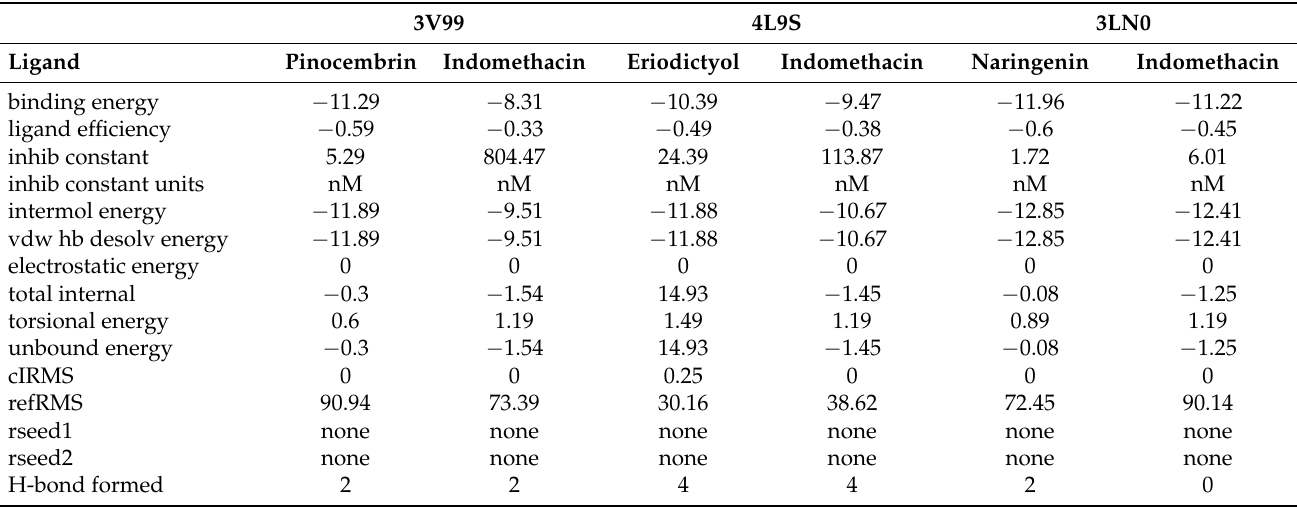
Figure 5. Top protein–ligand complex 3D structures, 2D and 3D ligand–protein interaction diagrams from LigPlot for anti-inflammatory properties. ( A ) 3V99–pinocembrin complex; ( B ) 4L9S–eriodictyol complex; ( C ) 3LN0–naringenin complex. Table 2. Molecular Docking Top scored ligand–protein complex data for receptors 3V99, 4L9S and